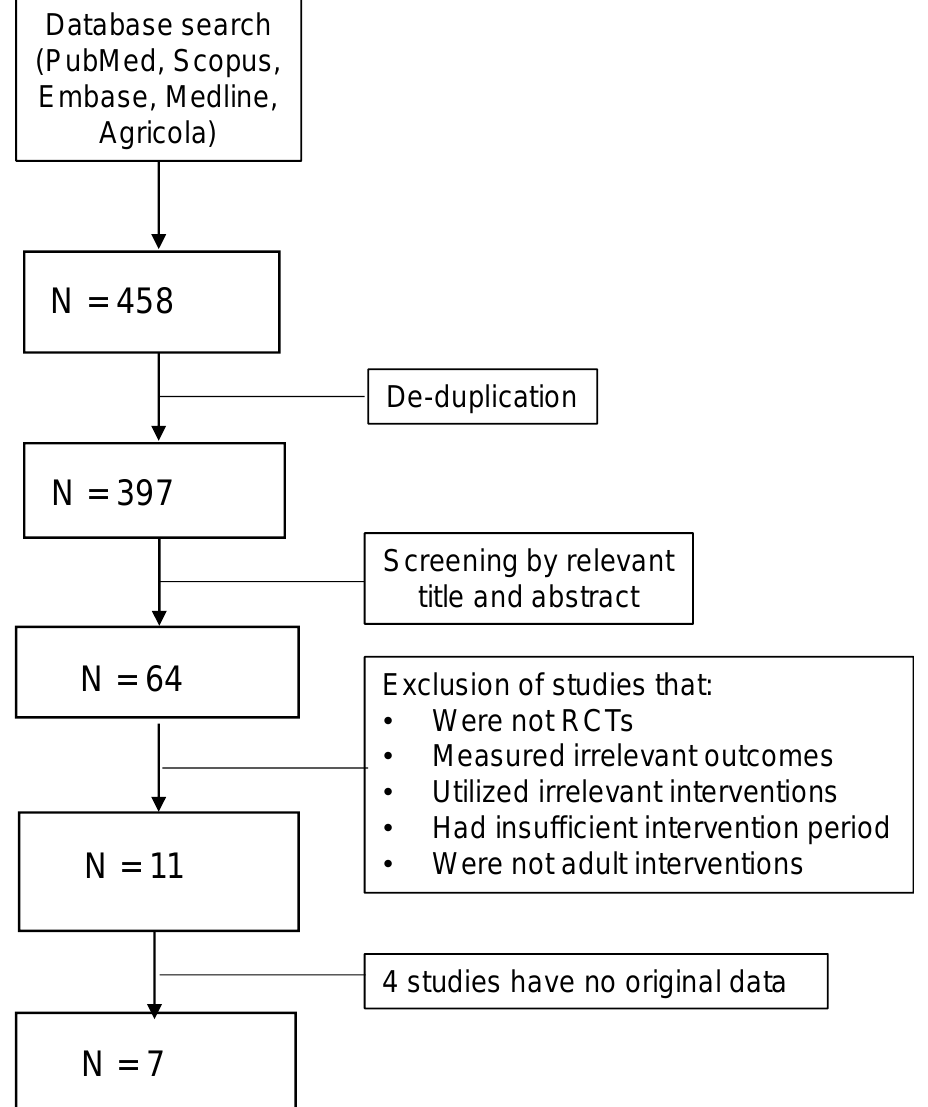
Figure 1. PRISMA flow diagram depicting the number of studies and their exclusion and inclusion in the meta-analysis.